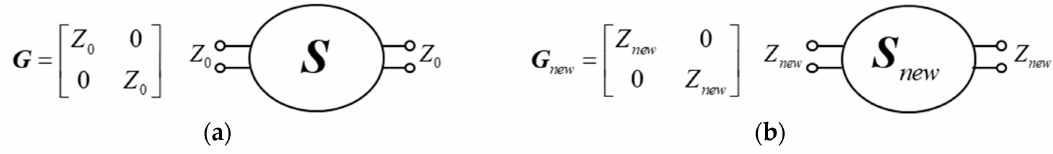
Figure 3. ( a ) Two-port S -parameter terminated by Z 0 ; ( b ) The renormalized two-port S -parameter terminated by Z new